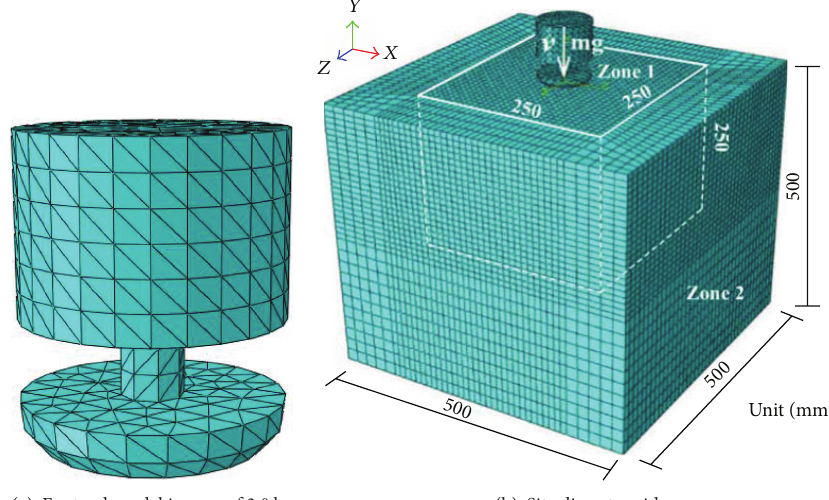
Figure 23: Grid of calculated model.